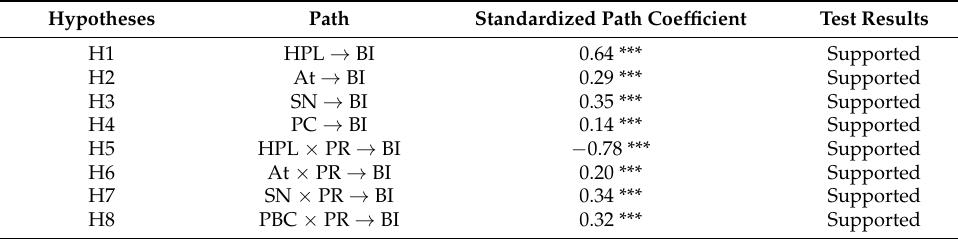
Table 5. Results of hypotheses